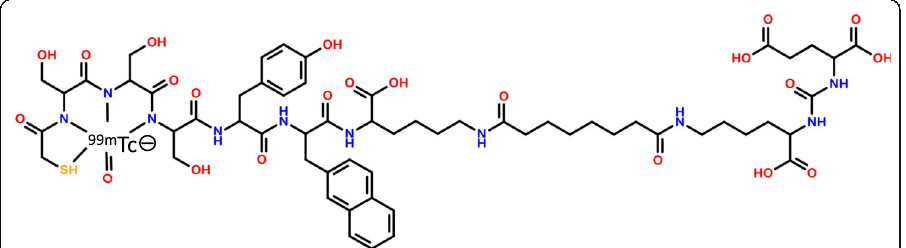
Fig. 2 Structure of [ 99m